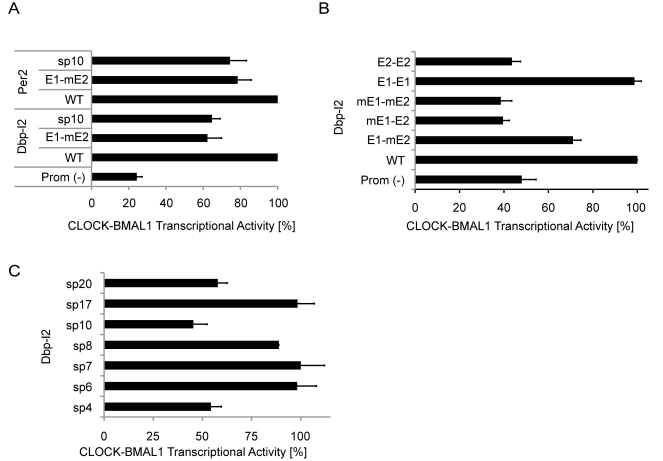
E1-E2 sites show increased transactivation compared to only E1 sites or E1-E2 sequences with longer spacers.(A) BMAL1-bound E1-E2 sites in the second intron of Dbp (Dbp-I2) and at the promoter of Per2 show an increased BMAL1/CLOCK transactivation compared to either the E2-mutated (E1-mE2) version or the 10-bp spacer version (sp10) (Student's one-tailed t test, p<0.05, n = 3). Empty vector (Prom[−]) is shown as a negative control. Wild-type (WT) levels are set to 100%. Error bars represent the standard error of the mean. (B) Mutation in the Dbp-I2 sequence shows that an E1 is needed for robust BMAL1/CLOCK transactivation. The wild-type version was compared to E1 mutated (mE1-E2), both E1 and E2 mutated (mE1-mE2), E2 replaced by E1 (E1-E1), and E1 replaced by E2 (E2-E2). All mutated versions have reduced activity compared to wild-type (p<0.005, n = 4), with the exception of E1-E1, which shows a level of transactivation similar to that of wild-type. (C) Modifying the spacer length of the Dbp-I2 tandem E-boxes from 4 bp to 20 bp shows a spacer preference at 6–8 bp, but also at 17 bp, which corresponds to a full helical turn of the DNA. Indeed, sp4, sp10, and sp20 have a significantly reduced activity compared to sp7 (p<0.01, n = 4).